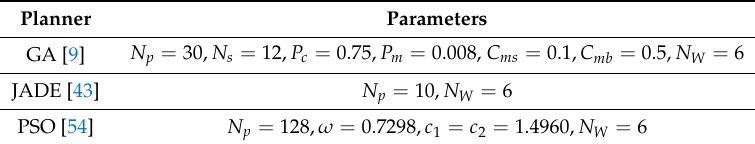
Table 6. Parameter settings of the stochastic path planning